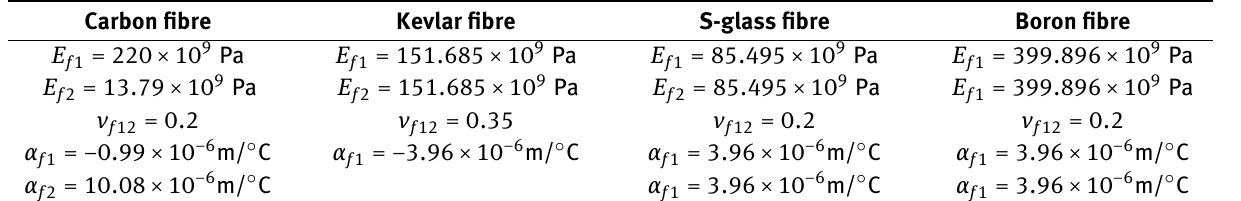
Table 7: Fibre material properties [31]